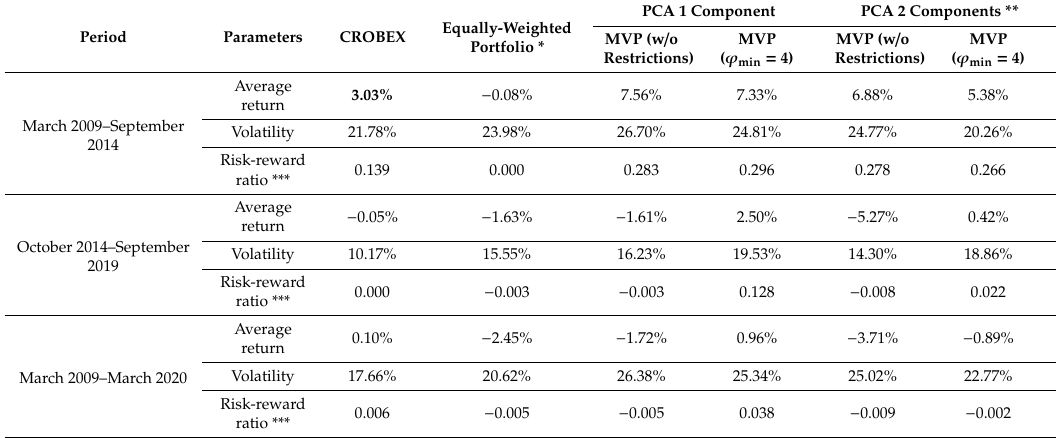
Table 2. Performance of the estimated MVP using “fundamentally-weighted” returns as inputs for PCA. Period